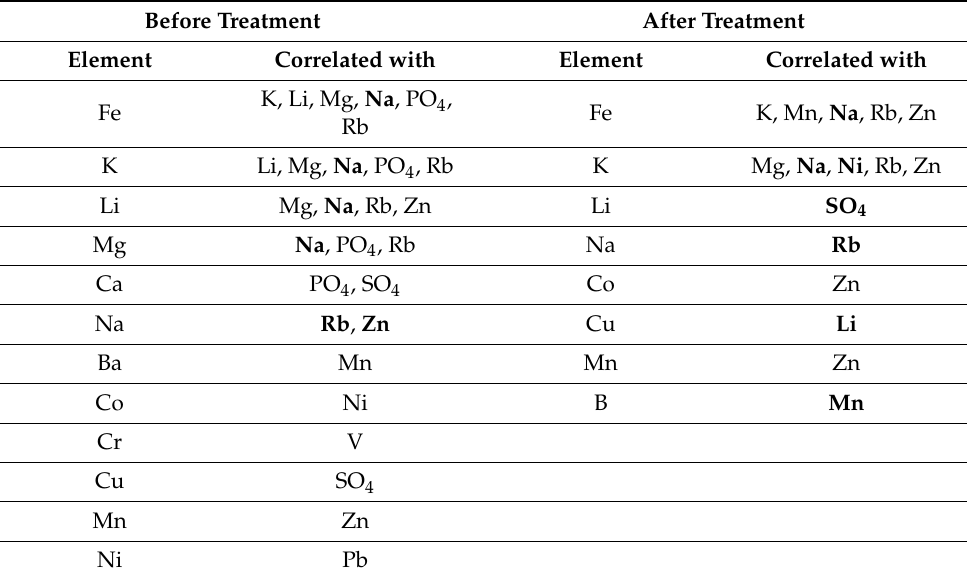
Table 6. Inter-elemental Spearman’s Rank Significant Correlations in sera samples of bipolar patients before and after treatment. Before Treatment After Treatment Element Correlated with Element Correlated